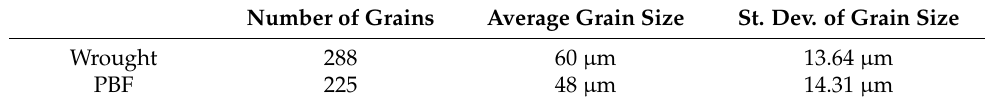
Table 6. EBSD grain map analysis.